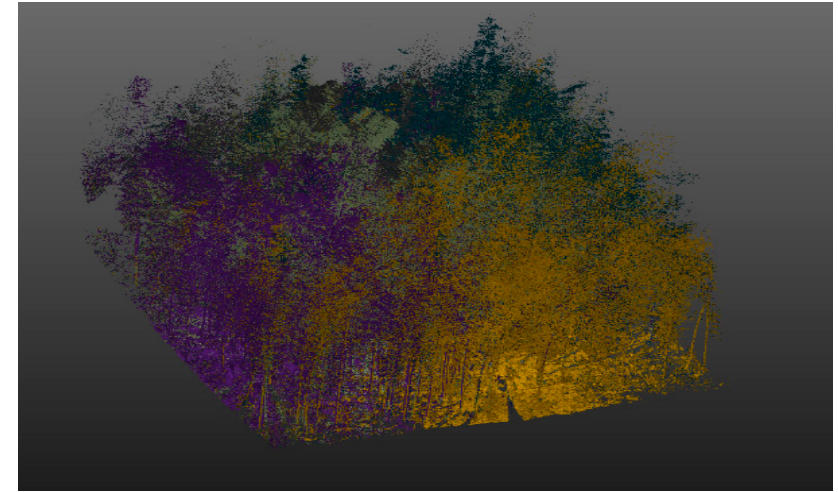
Figure 1. Preview of a sample. Different scanning points are indicated with different colors.